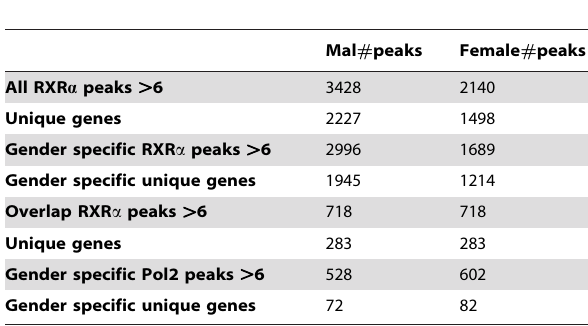
Table 2. Stratification of RXR a binding sites in male and female mouse liver according to peak